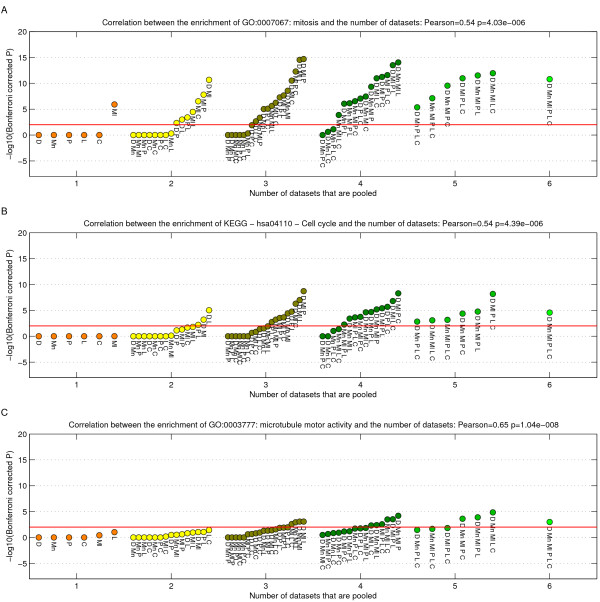
Enrichment of three gene sets relative to the number of datasets which is pooled. A) GO:0007067: mitosis B) KEGG – hsa04110 – Cell cycle C) GO:0003777: microtubule motor activity. Scatterplots indicate the minus log10 of the Bonferroni corrected p-values. The red line indicates the level at which 0.01 is reached.